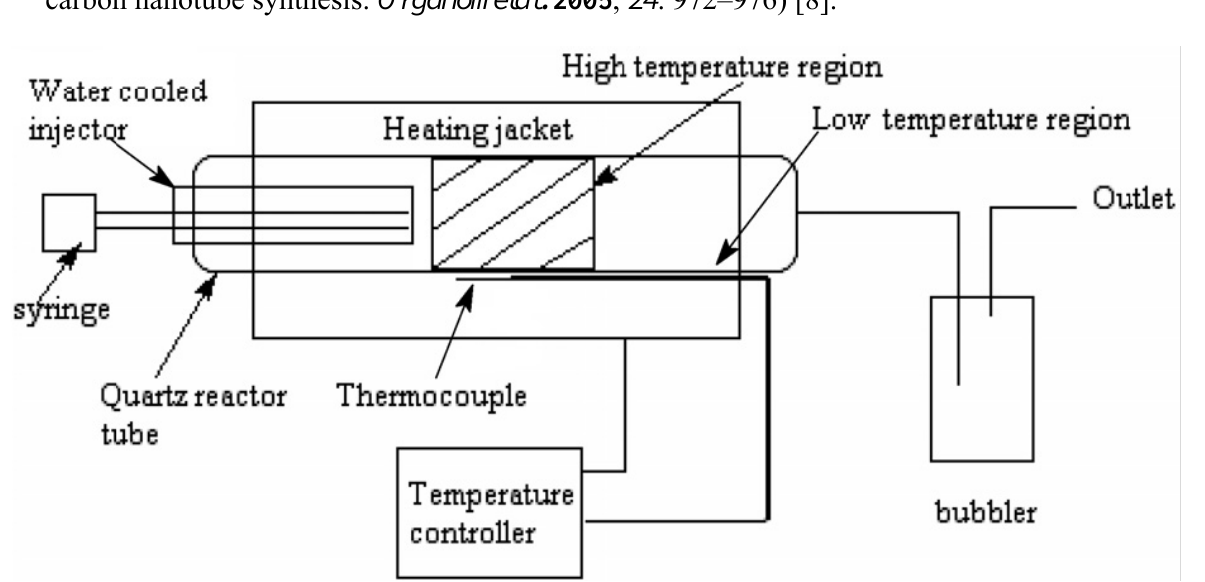
Figure 1. Floating catalyst CVD reactor for the synthesis of SCNMs (Mohlala, M.S.; Liu X.Y.; Robinson, J.M.; Coville, N.J. Organometallic precursors for use as catalysts